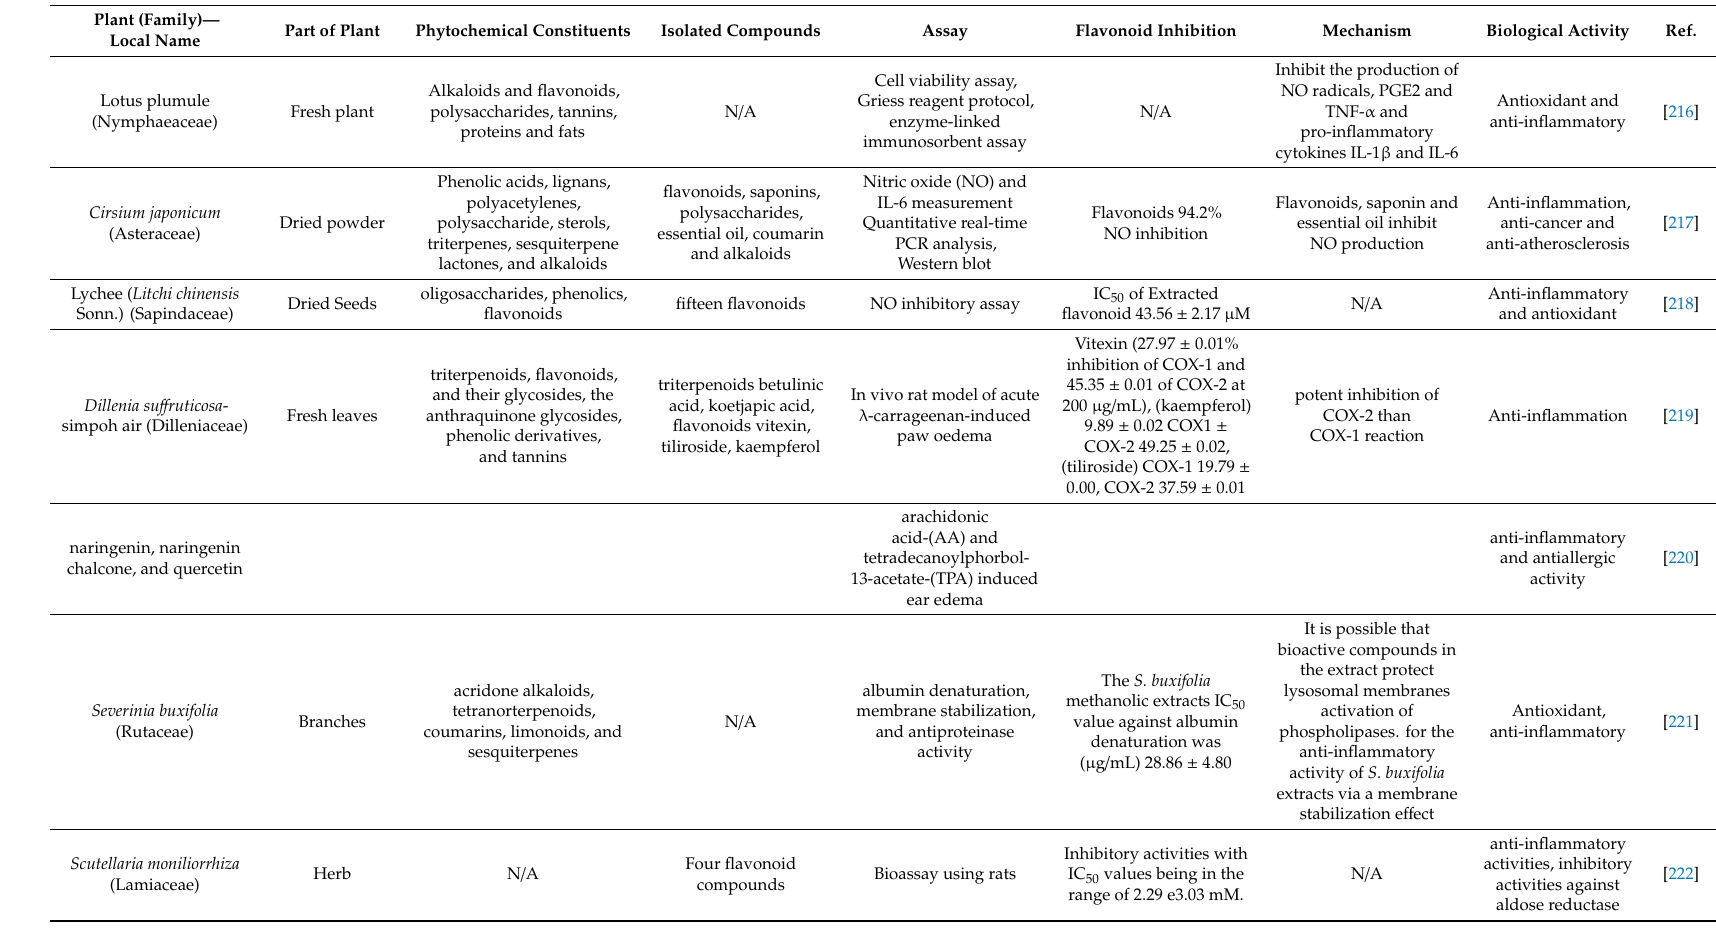
Table 5. Anti-inflammatory activity of